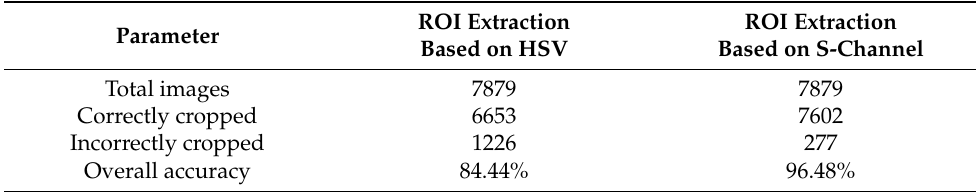
Table 3. Comparison of ROI Extraction methods.